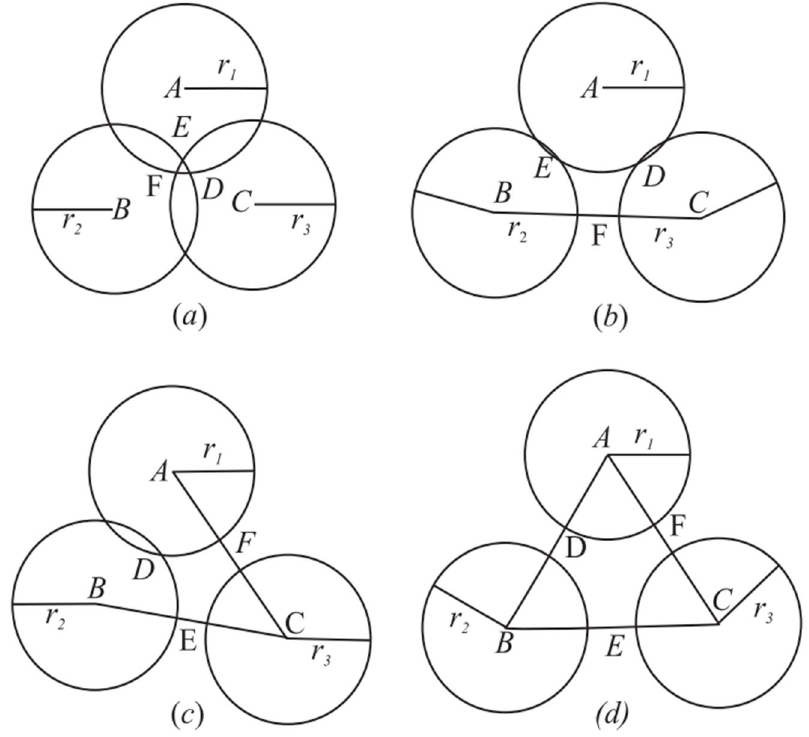
Figure 5. Four possible situations in trilateration calculation (( a )–( d ) present different positions). Based on the centroid algorithm mentioned above, the triangle formed by the common intersection (ABC) of the three circles is analyzed, and the distance between the preferred reference node and the unknown node is used to add a weight to each coordinate to reflect the difference. Among vertex contribution, (x A , y A ), (x B , y B ), (x C , y C ) are the coordinates of the three intersection points, which can be easily obtained. Not only is the RSSI data information added to the centroid operation, but the weight selection is also reasonably arranged. The information weight is adopted, and the concept of the correction coefficient is adopted so that the whole positioning accuracy has been greatly improved. However, in the actual test, the three circles often cannot meet at one point due to range error. Assuming that the mobile node is only active in the area of the reference node, the possible situation is shown in Figure